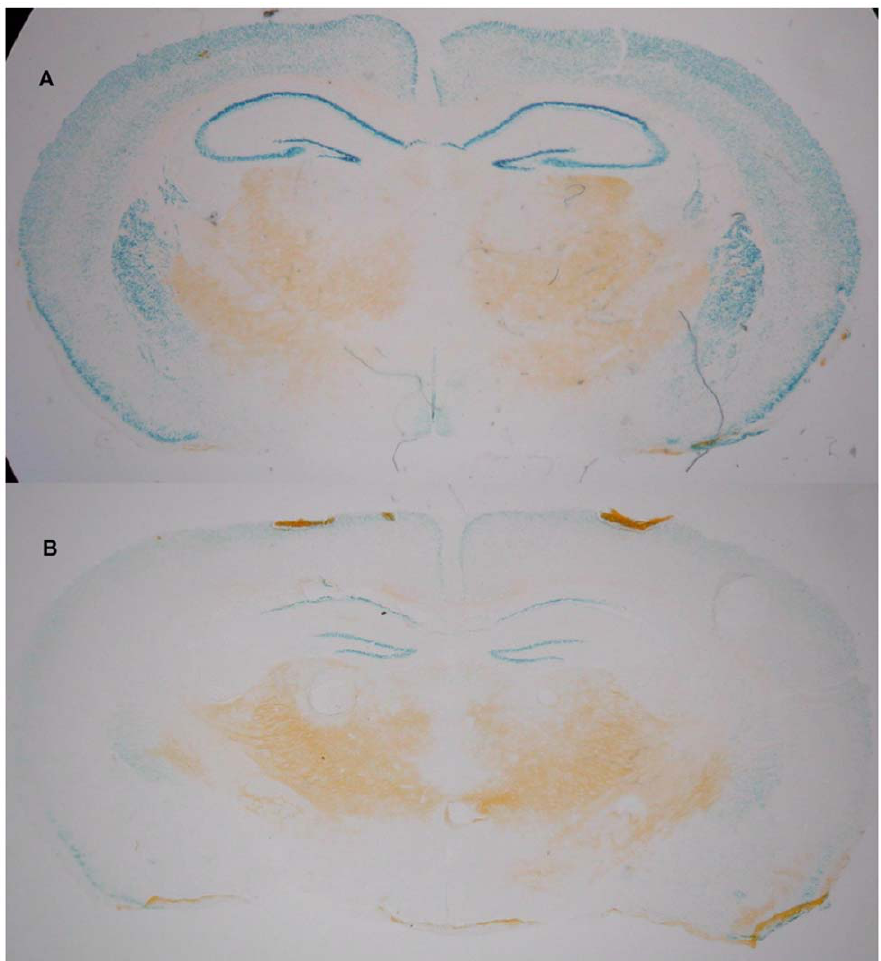
Figure 2. Sample of B-GAL activity in both WT and IR-hCB1 -/- mice either Dox treated or untreated. The expression of the reporter gene LacZ is visualized by b -GAL activity in the hippocampus from untreated (A) and Dox-treated (B) mice.